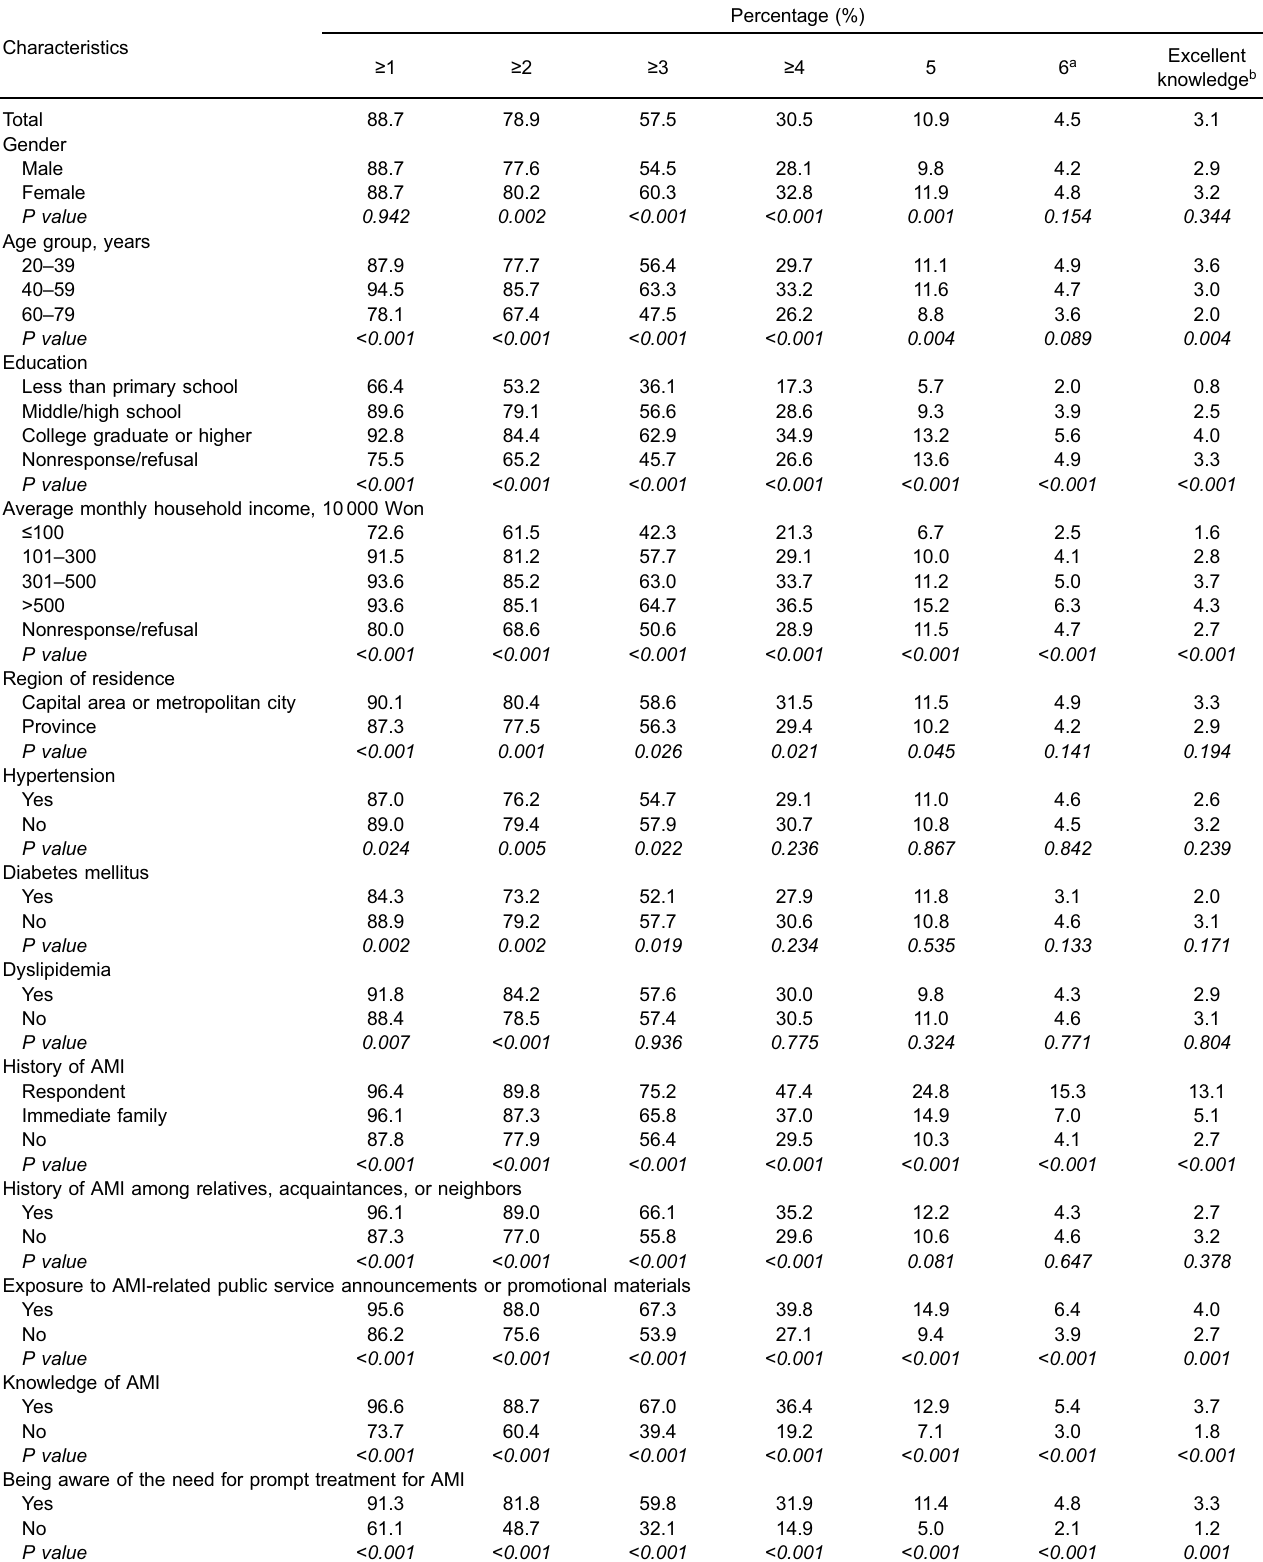
Table 3. Awareness of acute myocardial infarction symptoms by number of symptoms